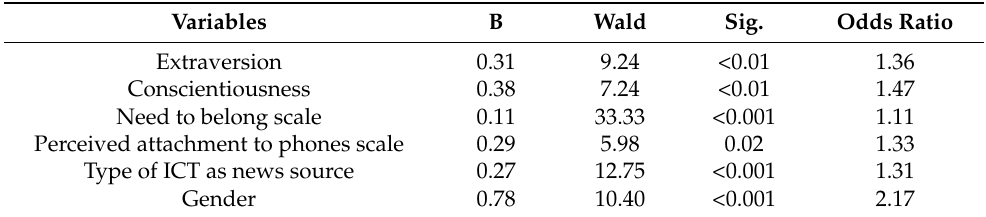
Table 3. Significant predictors for the perceived importance of social connectedness variable ( n =